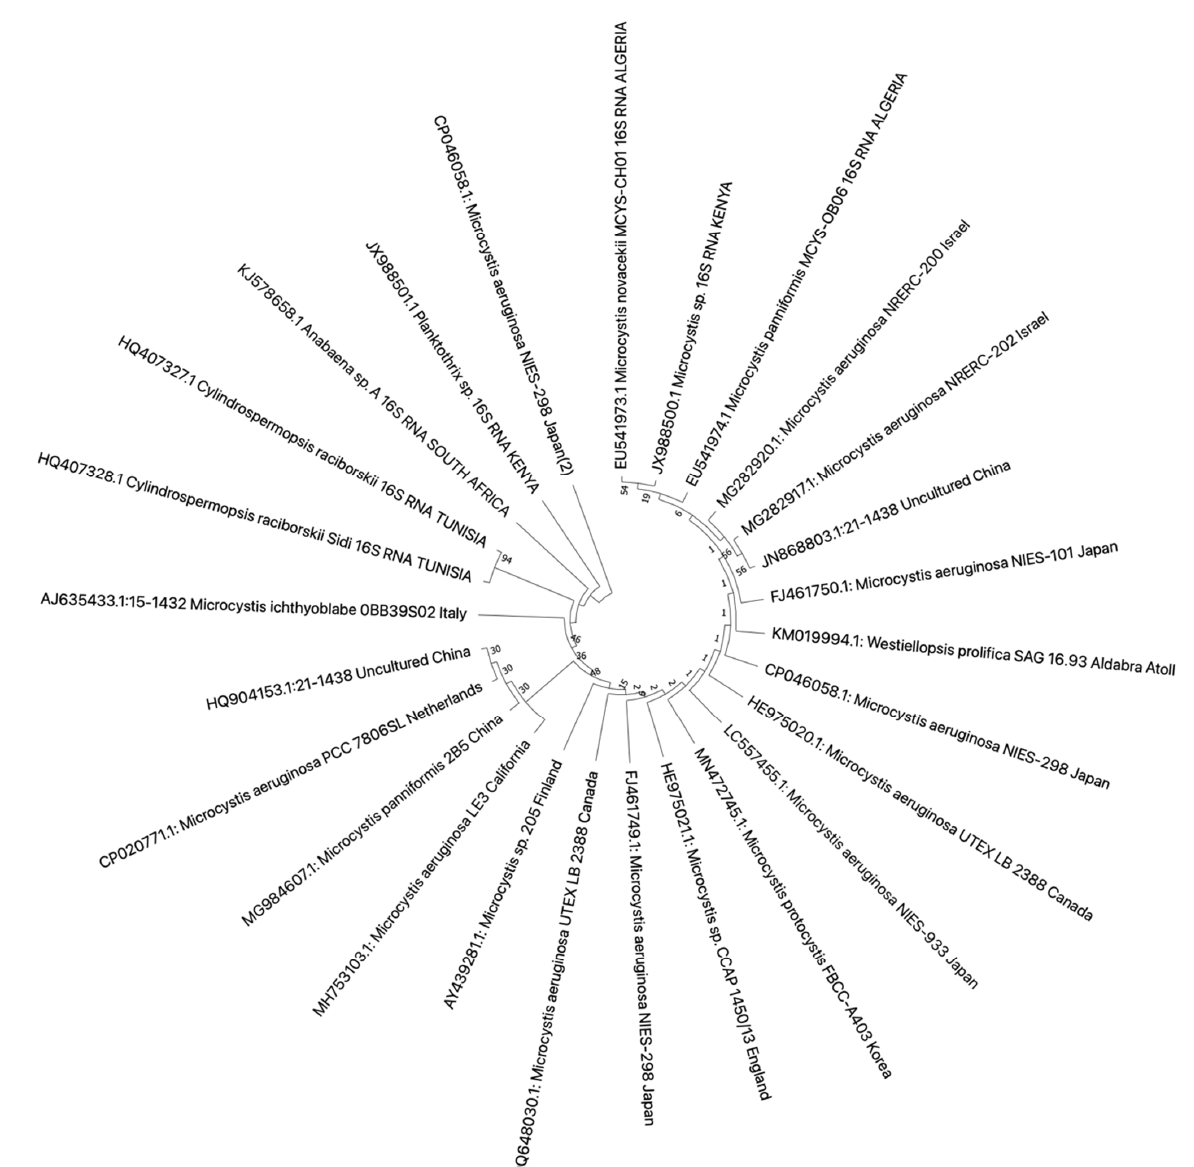
Figure 3. Neighbor-joining phylogenetic tree of the 16S rDNA gene of bloom samples and isolated cyanobacteria from Africa and other continents. The bootstrap consensus tree was inferred from 1000 replicates, and the evolutionary distances were computed using the maximum composite likelihood method. All ambiguous positions were removed for each sequence pair (pairwise deletion option). There were a total of 1462 bp in the final dataset. Evolutionary analyses were conducted in MEGA X version 11 for macOS.